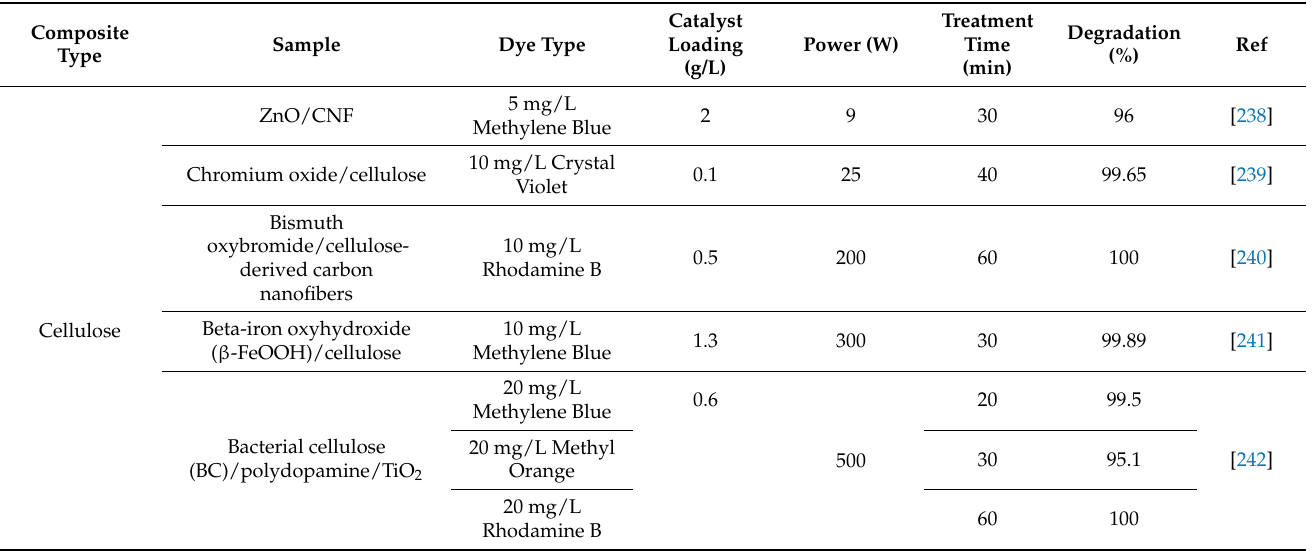
Table 4. Performance of cellulose composites, cellulose/metal doped composites, cellulose/non- metal doped composites, and cellulose/MOF composites as photocatalysts in the degradation of organic